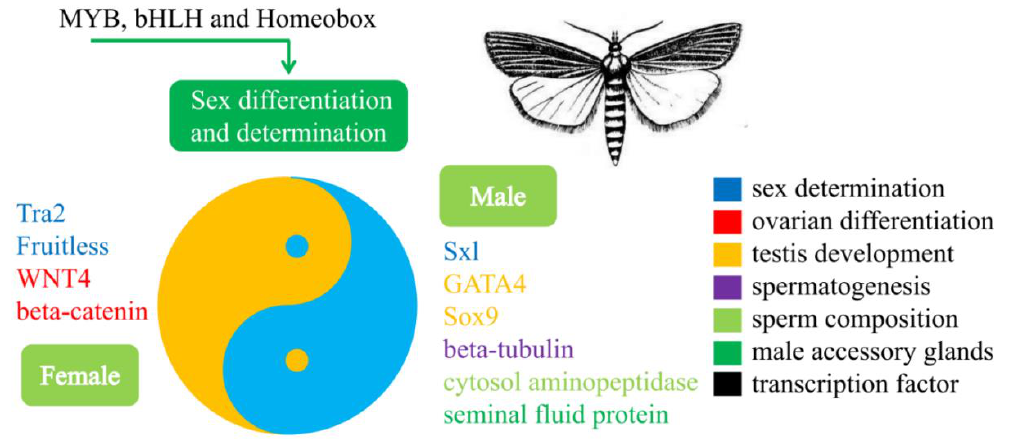
Figure 11. Genes related to sex determination and differentiation in Chilo sacchariphagus . The genes listed on the left of the circle showed higher expression in females, and the ones on the right side showed higher expression in males.